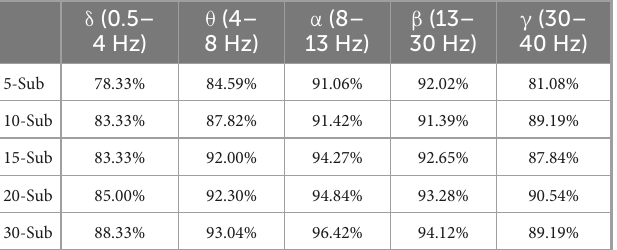
TABLE 5 Accuracy of classification of sleep stages in five frequency bands and five sub-periods under sub-period decision-making sleep stage classification method.